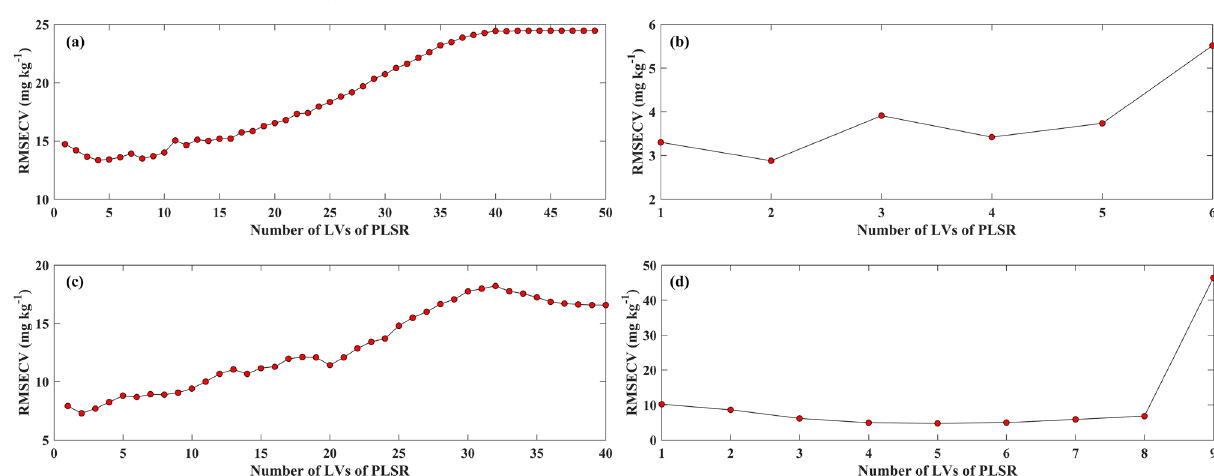
Figure 7. The scatter plots for determining the lowest RMSECV and the corresponding number of LVs. The number of LVs with the lowest RMSECV was used to fit the optimal PLSR in estimating Zn concentrations at four conditions concerning the ( a ) entire group based on L 6 , ( b ) clean group based on L 3 , ( c ) low pollution group based on L 5 , and ( d ) moderate pollution group based on L 1